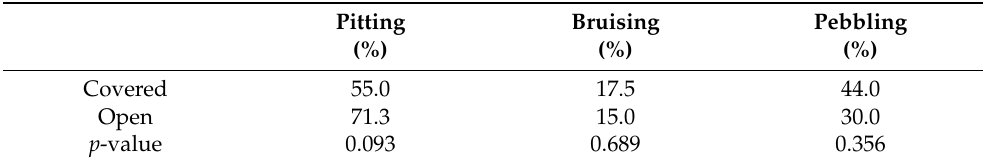
Table 5. Mean values for physiological storage disorders of ‘Santina’ sweet cherries grown under high tunnels (covered) or in the open in the Central Valley of Chile. Plot 1, growing season 2018/2019, Each value is the mean of four blocks. Characteristics with p -values below 0.05 denote significant after 45 days of cold storage and 3 days of shelf life.